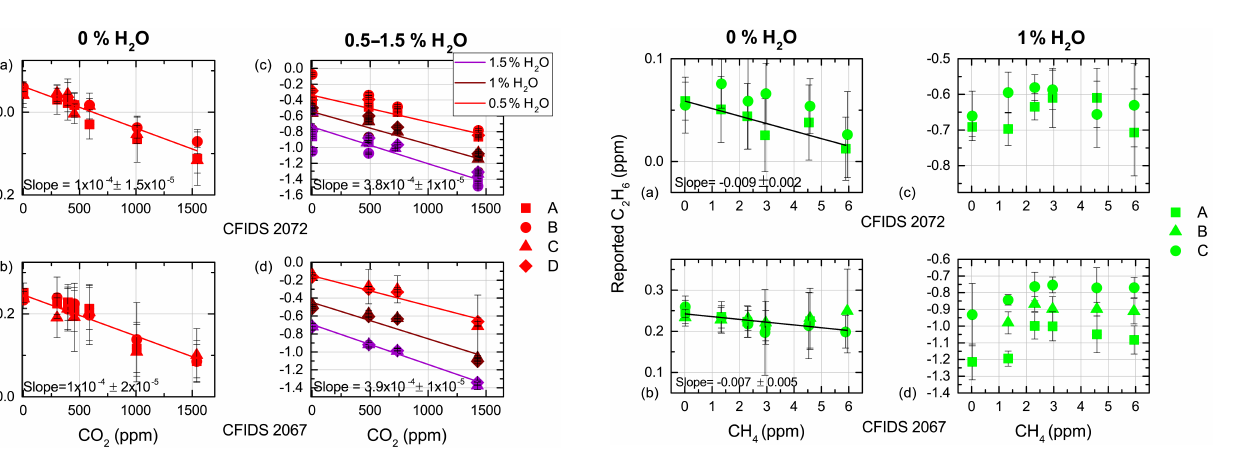
Figure 5. Relationship between reported C 2 H 6 and concentration changes of CO 2 for instruments CFIDS 2072 and 2067 at vary- ing values of H 2 O, at 0ppmC 2 H 6 (within our instrumental pre- cision). For each plot the bottom axis indicates the concentration of the targeted gas (CO 2 ) . Plots (a) and (b) are at 0% H 2 O, (c) and (d) are experiments at varying humidities, distinguishable by colour. The legend denotes repetitions of the experiment. The error bars in each plot denote the standard deviation of each measurement. The R 2 values for the experiments at 0% H 2 O are 0.9 and 0.8 for all other H 2 O experiments for both instruments.